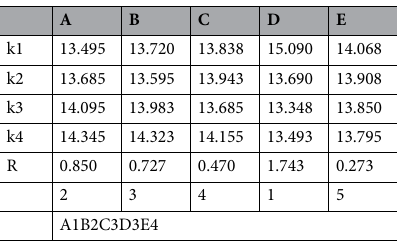
Table 5. Volume shrinkage range analysis.